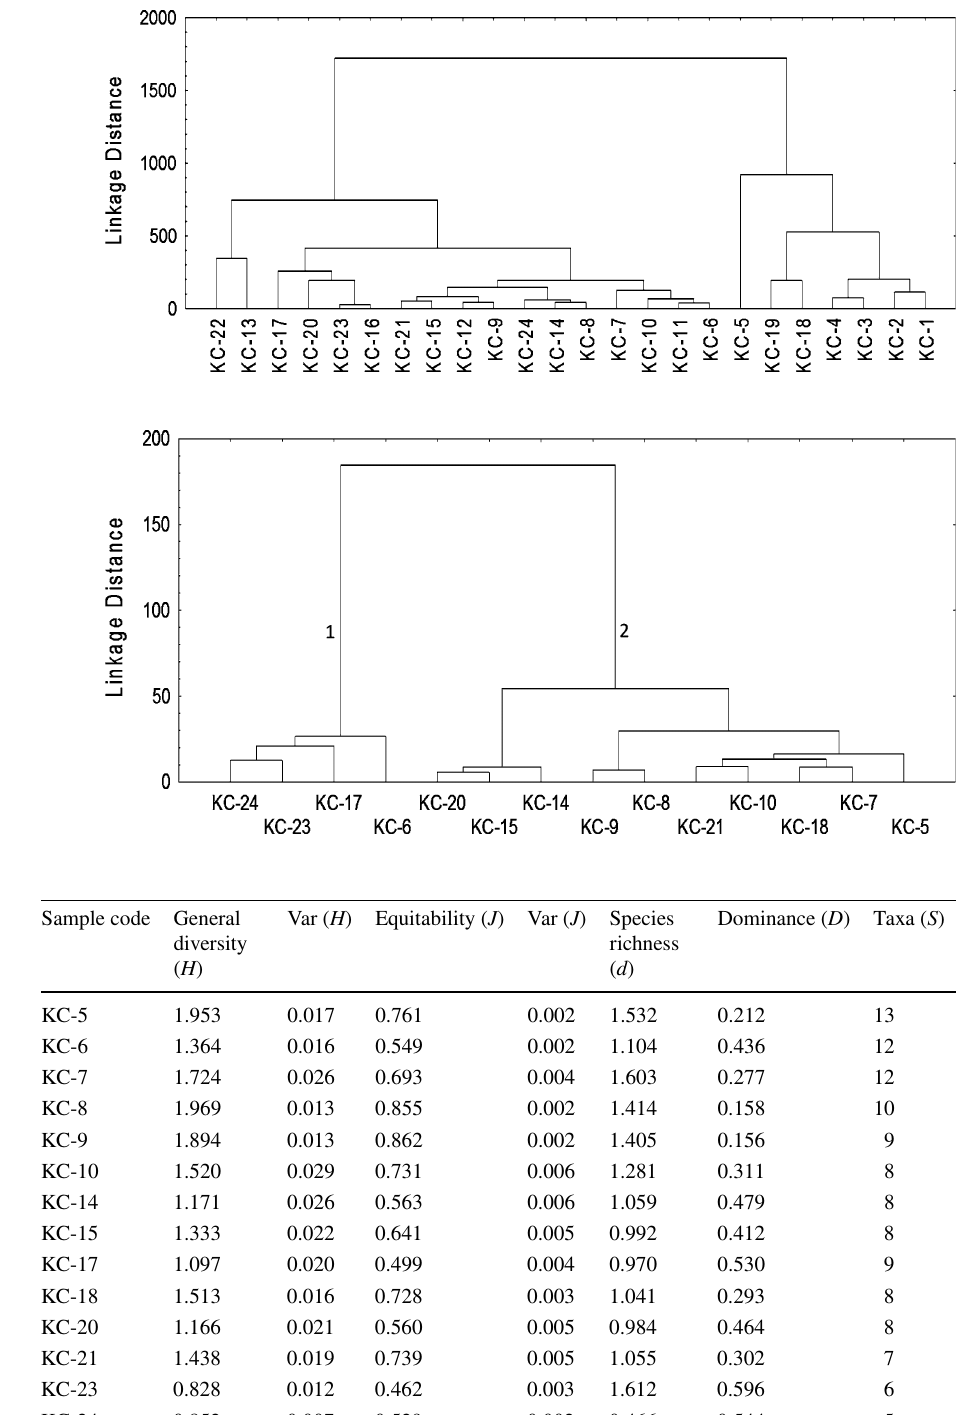
Table 6 General diversity ( H ), equitability ( J ), their variances, species richness ( d ) and dominance ( D ) of biota